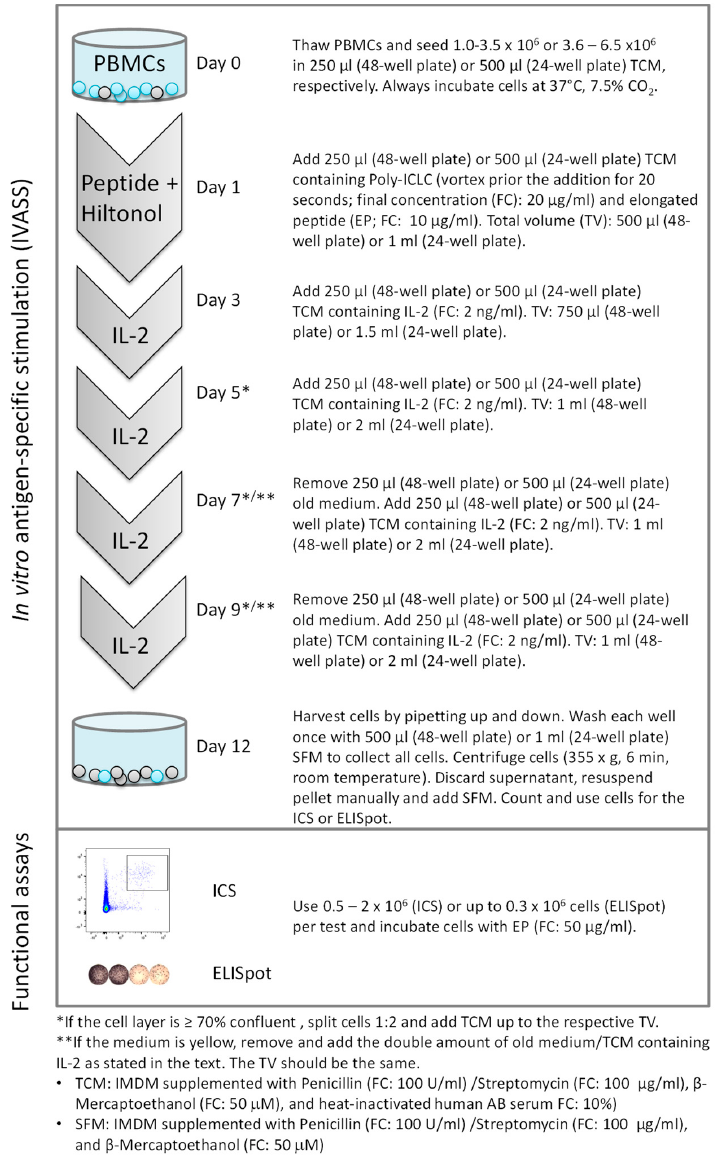
Figure 5. Protocol scheme for the simultaneous detection of antigen-specific CD8 + and CD4 + cells after in vitro expansion using elongated peptides.